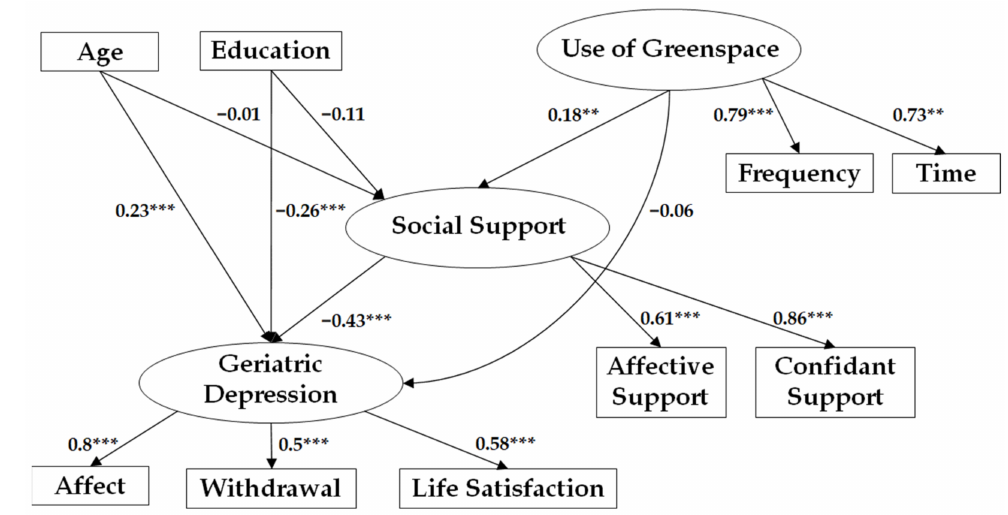
Figure 2. Path diagram of the Structural Equation Model tested. ** p < 0.01; *** p <